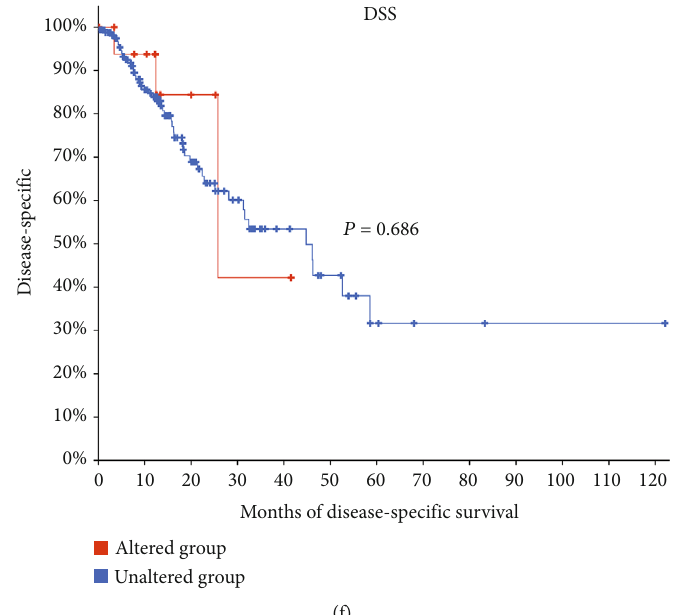
Figure 3: Genetic alteration and prognosis of YY1 in ESCA (cBioPortal). (a) The oncoPrint of YY1 alterations in ESCA. (b) The mutation sites of YY1 in ESCA. (c – f) Survival analyses of genetic alteration of YY1 in